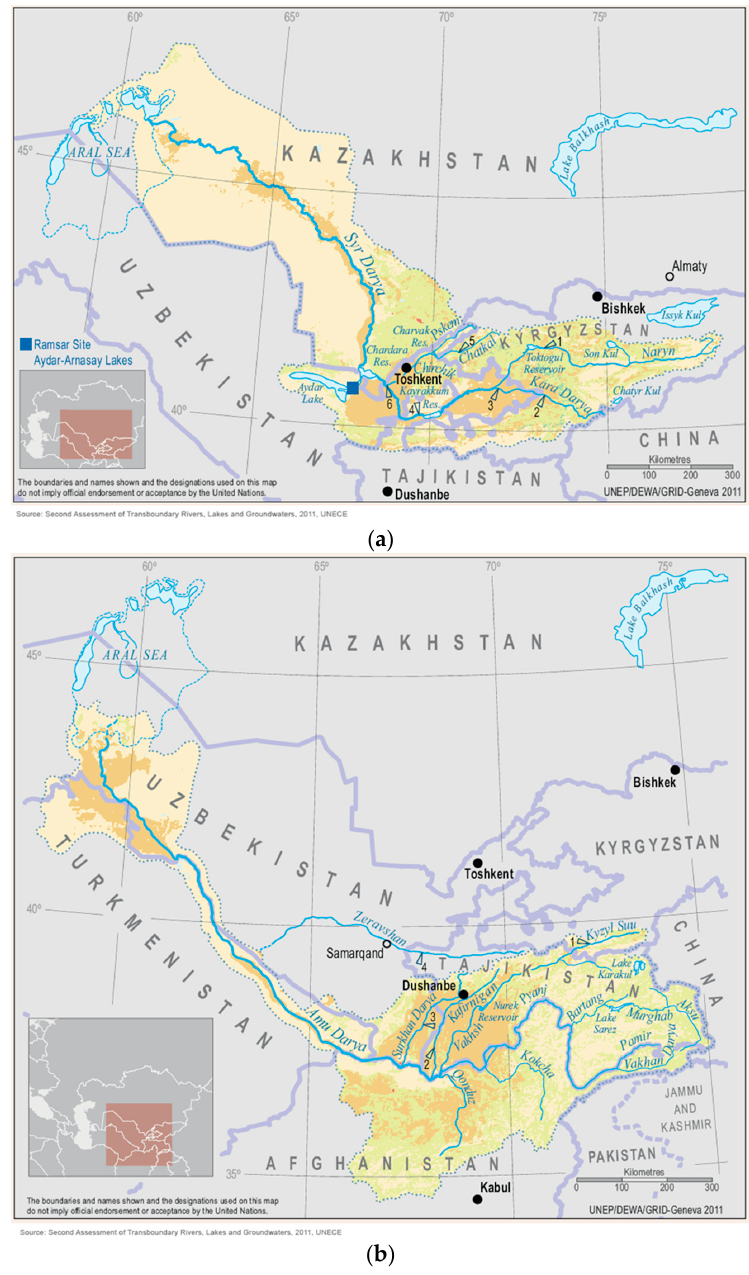
Figure 2. The Syr Darya ( a ) and Amu Darya River ( b ) Basins [22].